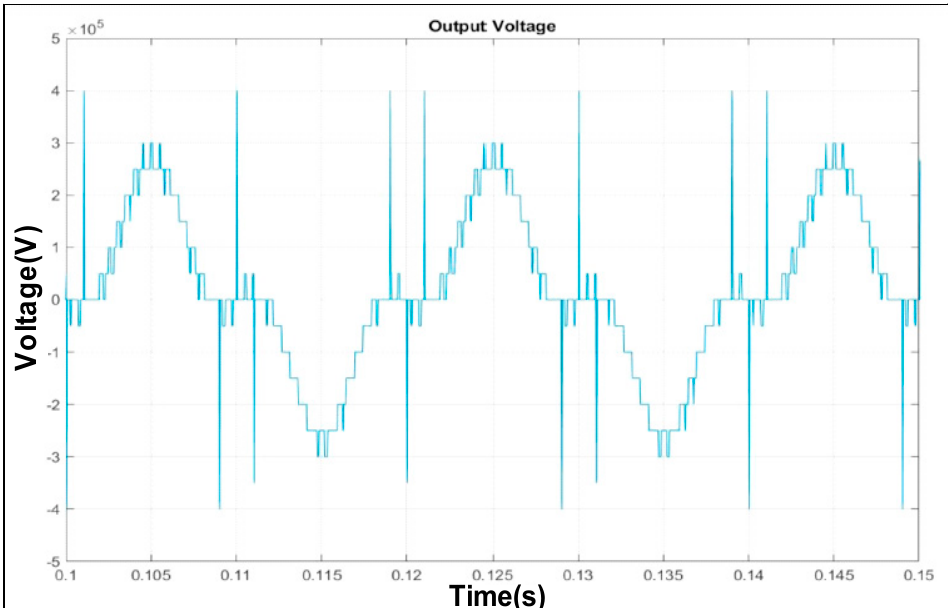
Figure 3. Voltage for a single AC side cascaded configuration including 4H-bridges [26].